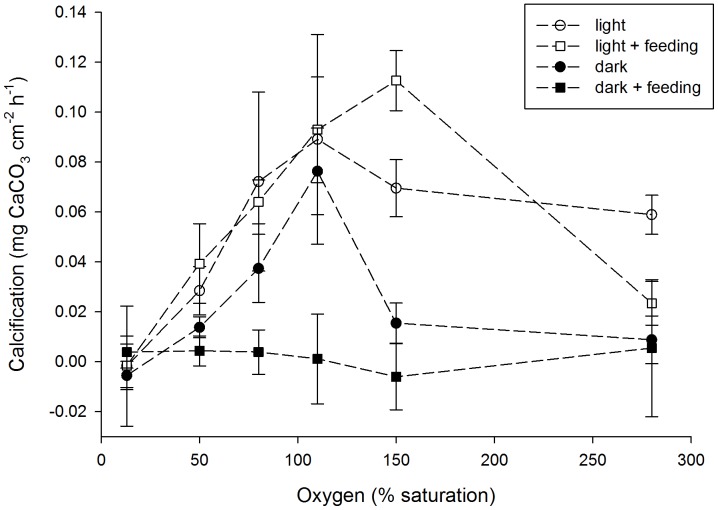
Effects of oxygen and heterotrophy on light and dark calcification of Galaxea fascicularis.Feeding quantity was 150 Artemia nauplii polyp−1. QI in light was 250 µmol m−2 s−1. Values are means ± s.d. (n = 4).